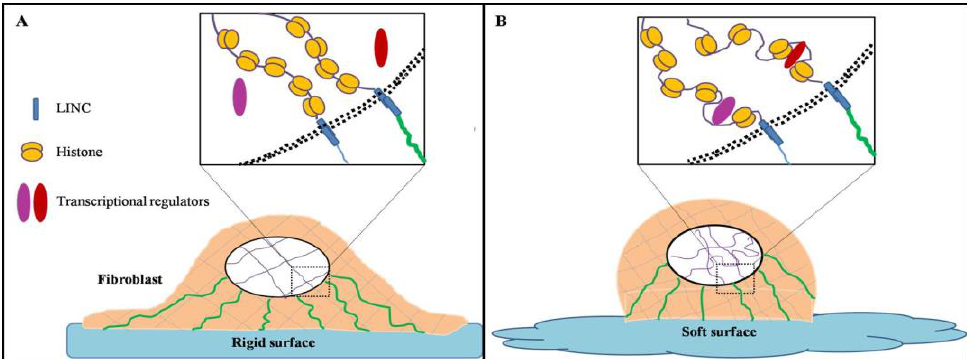
Figure 4. Schematic model of surface mechanotransduction modulating chromatin structure: Biomimetic surfaces can modulate chromatin structure in the same way as extracellular matrices can (in a natural way). ( A ) Fibroblasts on rigid surface: Fibroblasts on a rigid surface may have less flexible chromatin structures which does not allow transcriptional regulators to access the DNA. ( B ) Fibroblasts on soft matrix: Fibroblasts on soft matrix (e.g., extracellular matrix (ECM) of the brain) have a more flexible chromatin structure allowing specific transcriptional regulators to work and desirable gene expressions (for neuronal regeneration) are